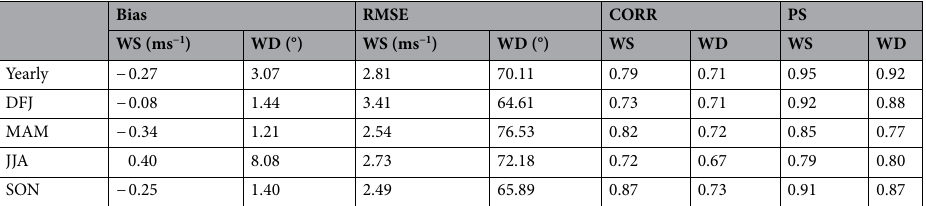
Table 1. Yearly and seasonal mean wind speed and wind direction bias (CCLM – FINO1), root mean square error (RMSE), correlation (CORR), and Perkin’s score (PS) of CCLM compared with FINO1 in the period 2008–2009.